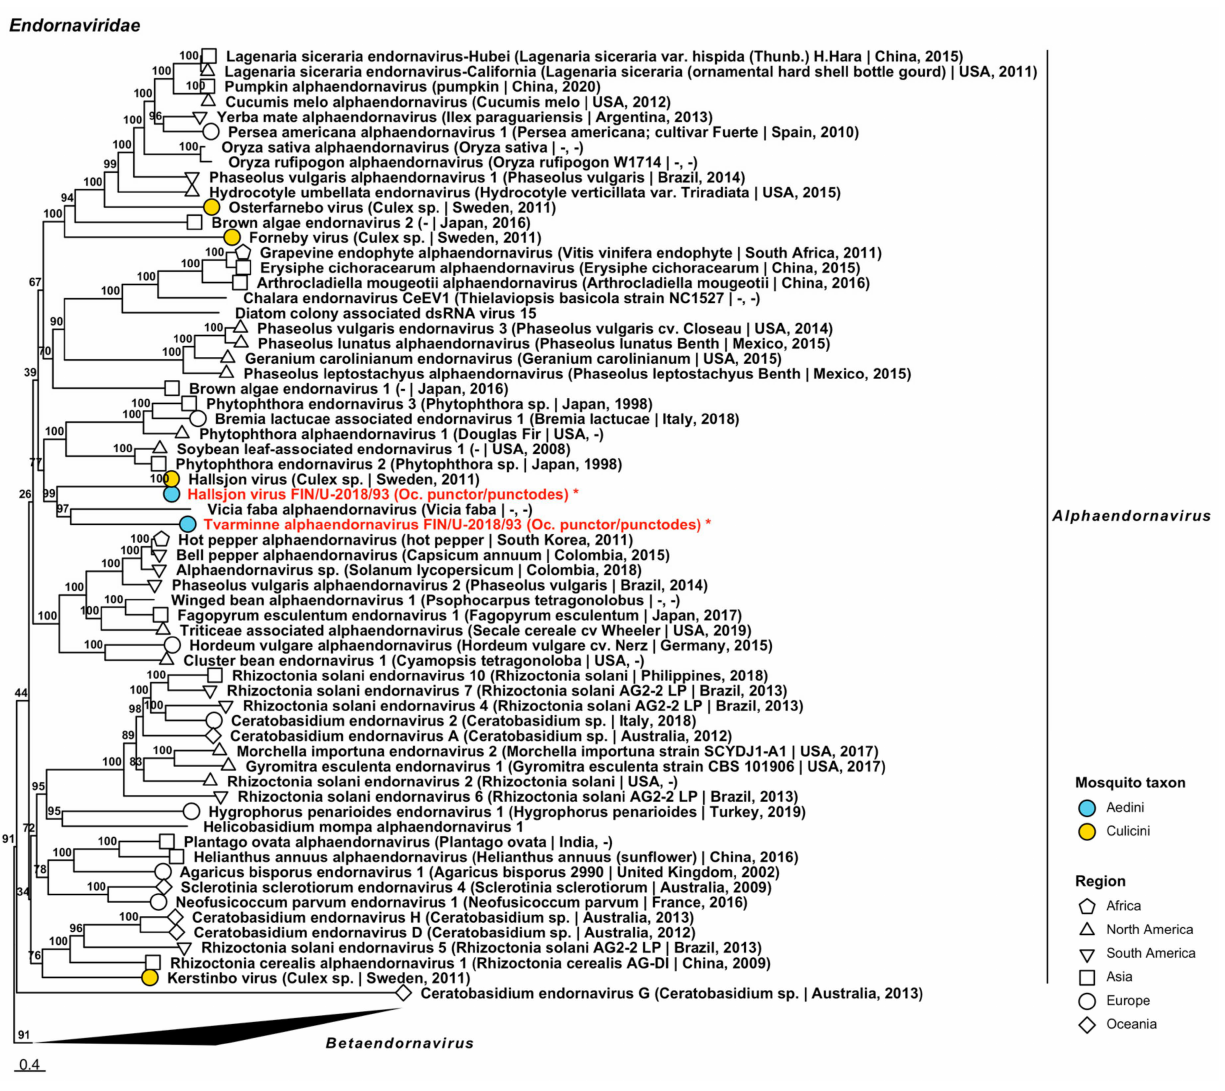
Figure 2. Maximum likelihood tree of Endornaviridae . Tentative novel viruses are displayed in red and the mosquito species from which they were derived are in parentheses. Sequences from GenBank are black and display the following information after the virus or species name: “(sampled organ- ism(s)|collection country, collection year)”. Tip colours represent the tribe of mosquito from which viruses were obtained. Tip shape represents the continent or region from which the specimens were collected. Trees were constructed from amino acid sequences of virus polymerases >1000 nt, aligned with MAFFT and computed with IQ-TREE2 using ModelFinder and 1000 bootstraps. Asterisks denote that the complete genome was